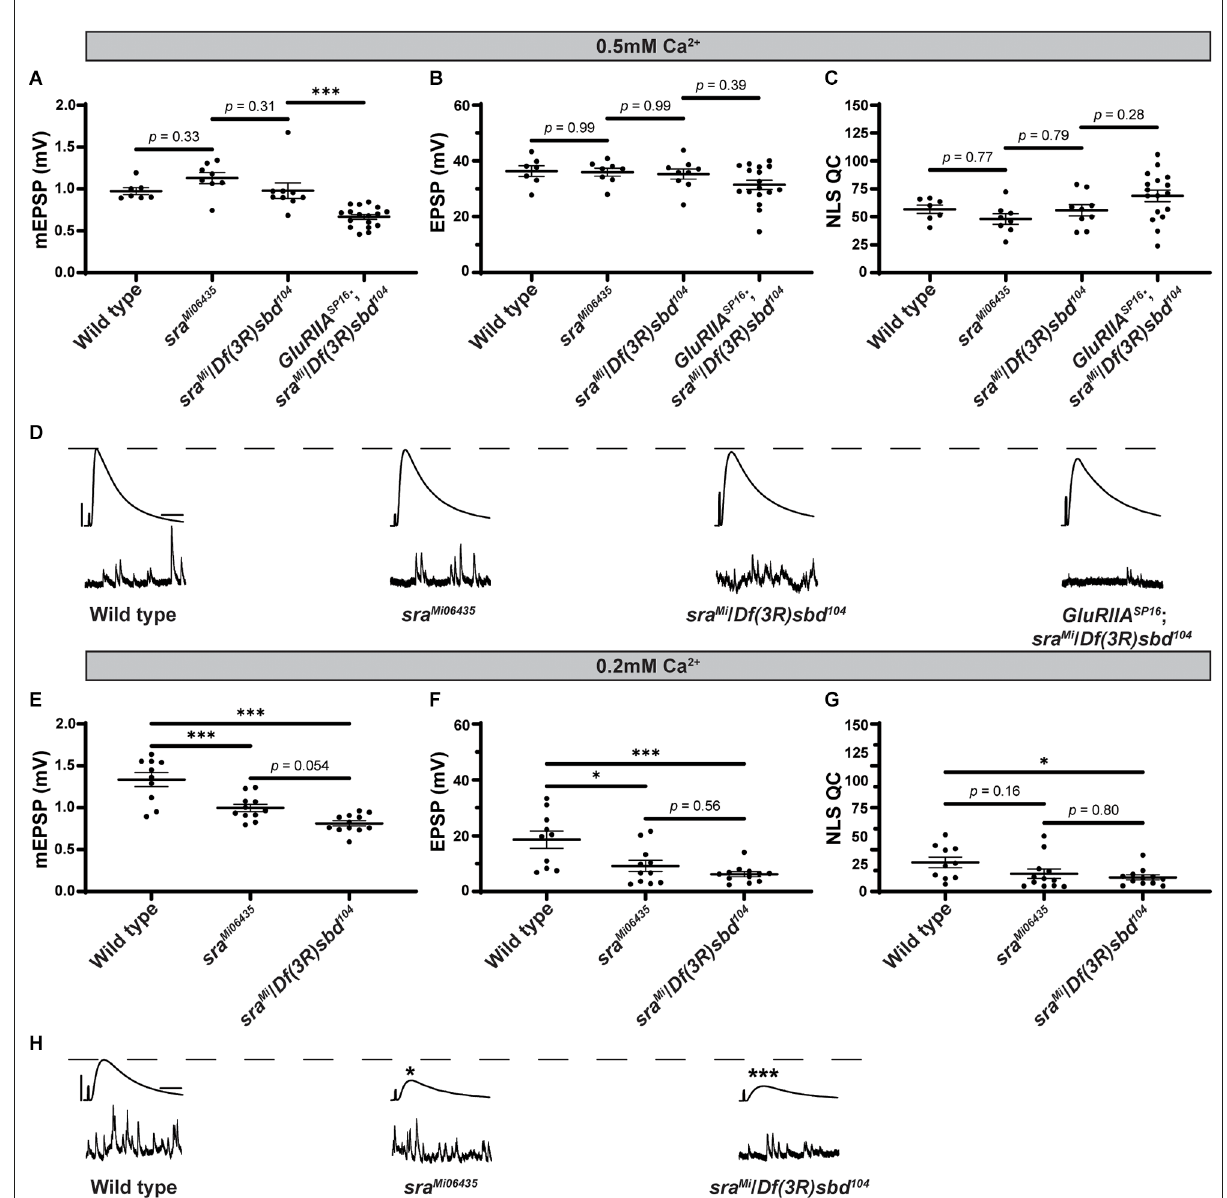
FIGURE2 Global sra mutation does not preclude PHP but does show an evoked amplitude decrease in low calcium conditions. (A–C) Quantification showing average mEPSP, EPSP amplitude, and NLS quantal content in sra Mi 06345 , sra Mi 06345 / Df(3R)sbd 104 , and GluRIIA SP 16 ; sra Mi 06345 / Df(3R)sbd 104 . (D,H) Representative electrophysiological traces of EPSPs (above) and mEPSPs (below). Scale bars for all traces are y = 10 mV (1 mV), x = 20 ms (500 ms) for EPSPs (mEPSPs). (E–G) Experiments conducted in low calcium (0.2 mM). Quantification showing